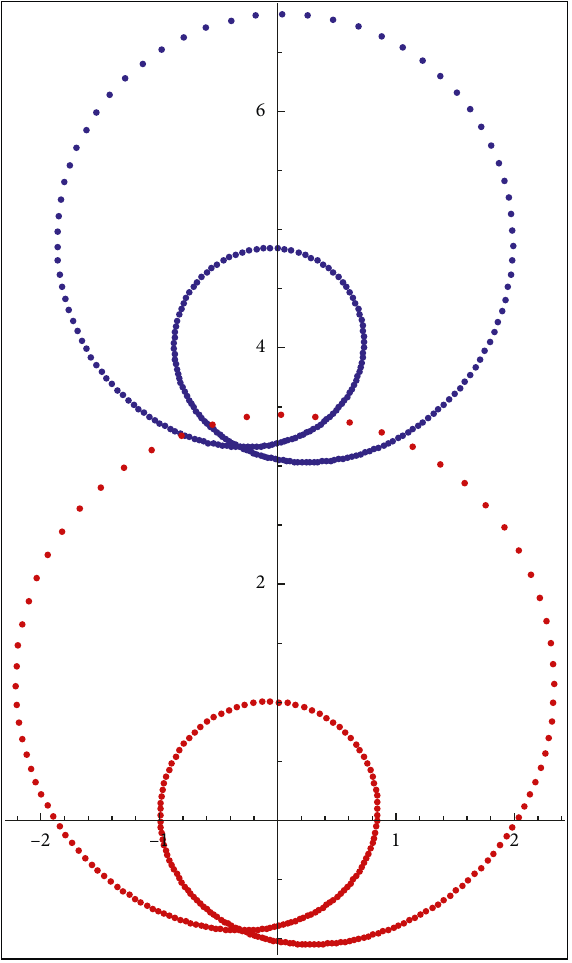
( t ) (top curve) and g 0